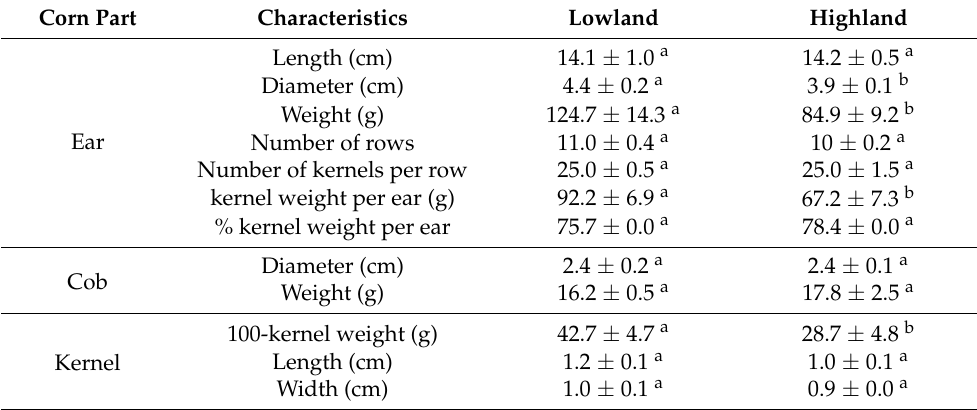
Table 1. Physical characteristics of purple corn from lowland and highland geographical zones in Peru. Corn Part Characteristics Lowland Highland Length